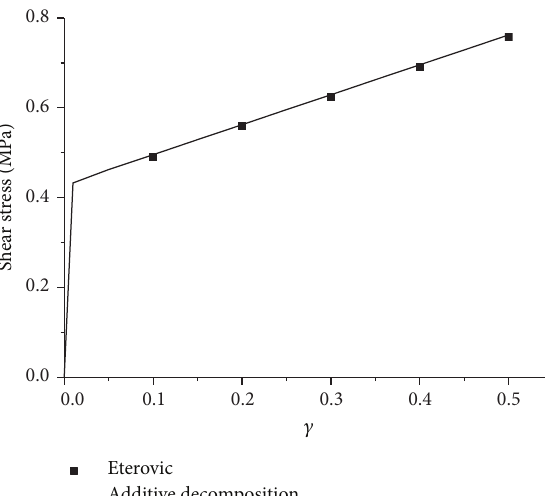
Figure 3: Strain-stretch relations for various strain measures.